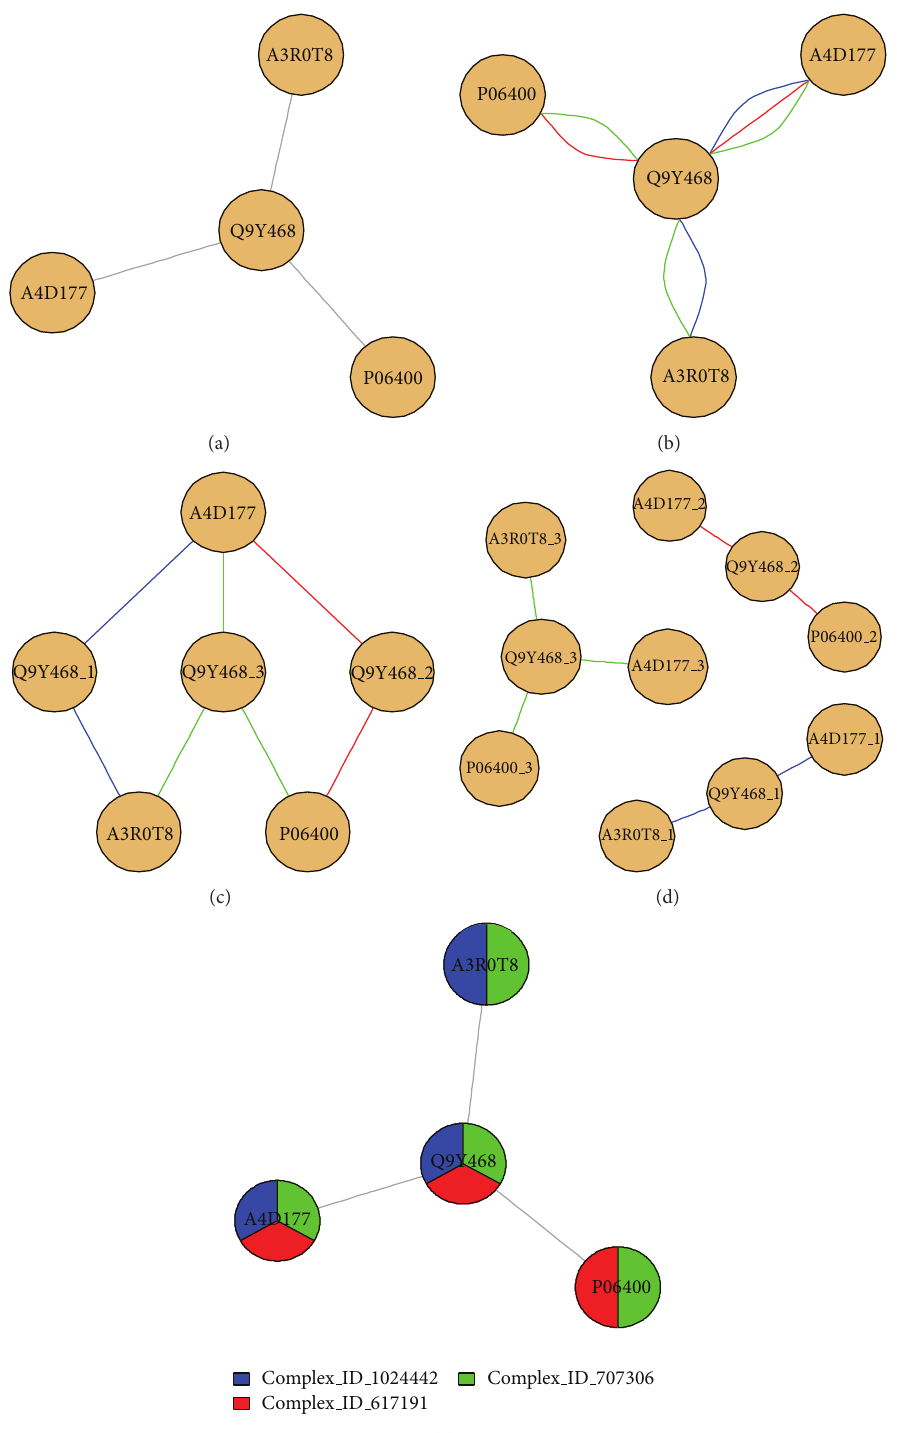
Figure 3: Representation and visualization methods of nested complexes. (a) Maximal complex, hiding nesting. (b) Multiedge representation. (c) Multihub representation. (d) Multinode representation. (e) Node-attribute representation. The multiedge view keeps one node per protein and represents every different complex with a different edge color. The multihub view splits the hub of the complex into three different nodes, one for each complex. The multinode just generates three separated complexes (distinct nodes and edges in the same graph). The node- attribute view uses single edges and, here, stores the information on complex membership as a pie for each